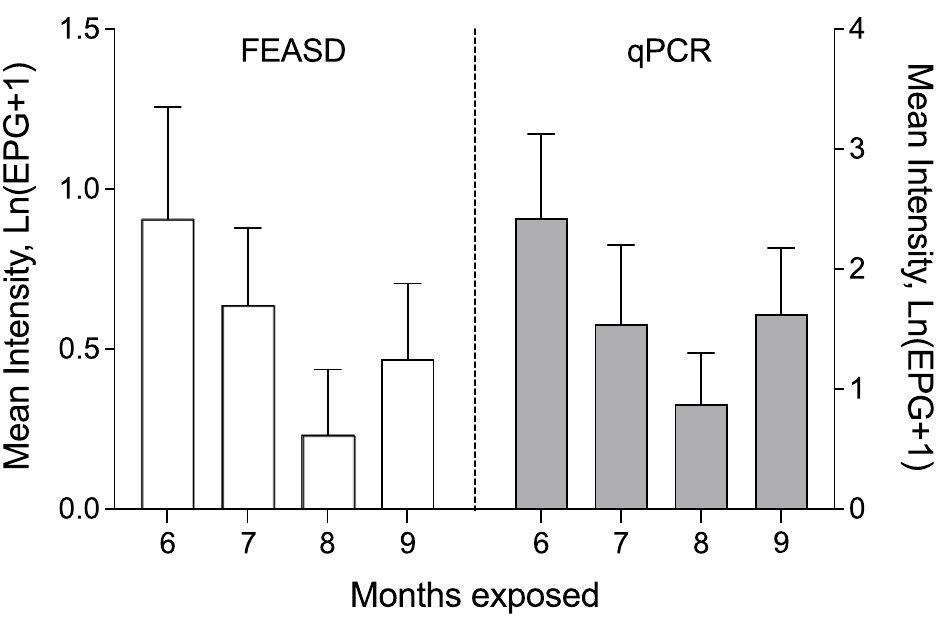
Fig 2. Natural log transformed intensity of S . japonicum infection among water buffalo by FEASD& qPCR at 6 to 9 months post-exposure. Error bars represent 95% confidence.